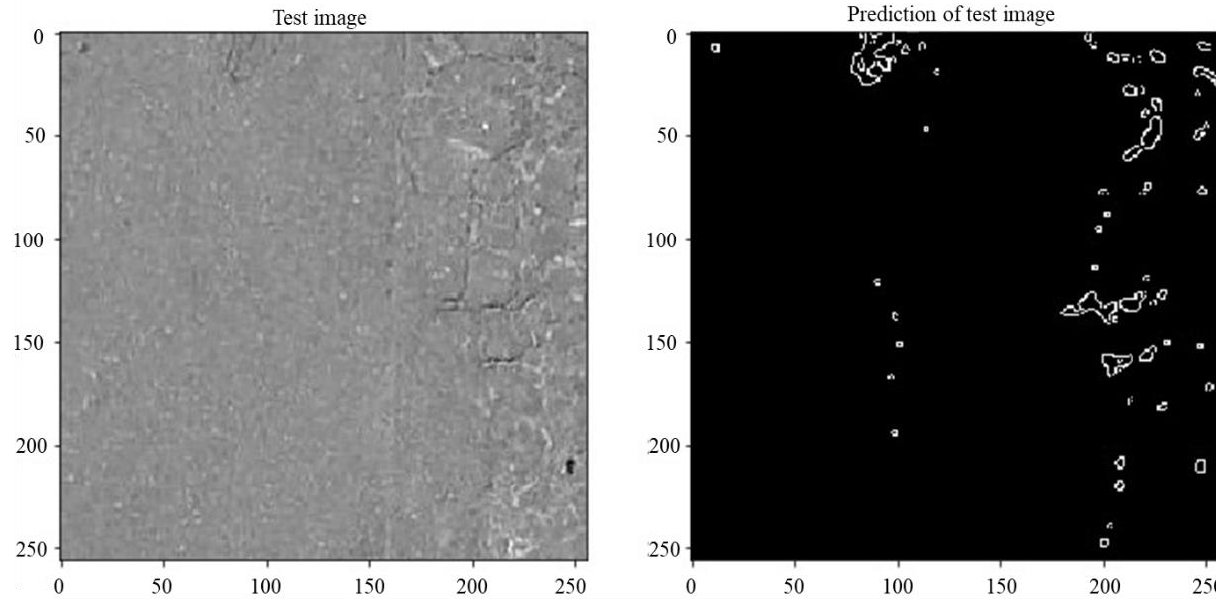
Figure 9. Predicting the cracks from the trained model using a new image.